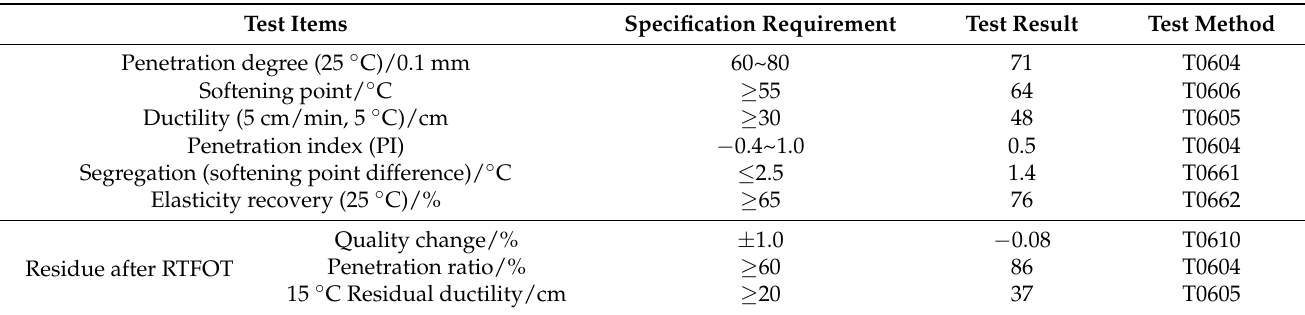
Table 2. SBS-modified asphalt (PG76-22) technical index.